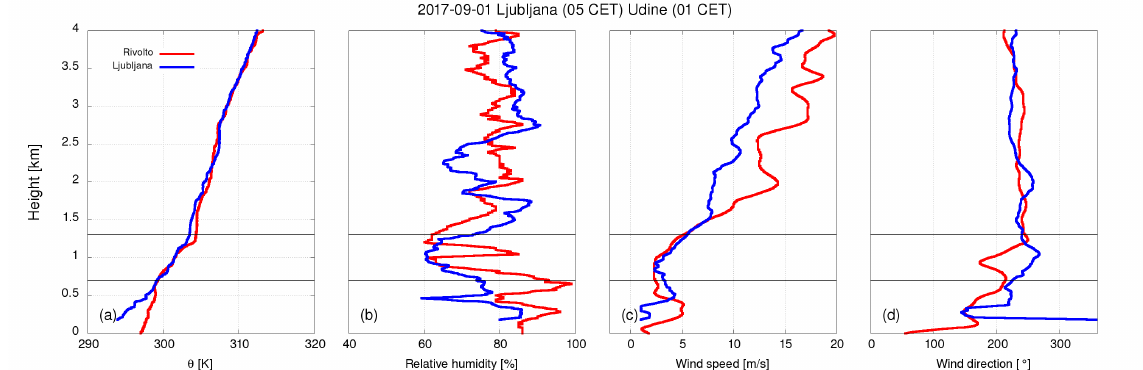
Figure 3. Radiosonde profiles from Ljubljana (blue) at 5:00 CET and Rivolto (red) at 1:00 CET on 1 September 2017. ( a ) Potential temperature ( θ ); ( b ) Relative humidity; ( c ) wind speed and ( d ) wind direction. Horizontal lines at 0.7km and 1.4km denote significant slope changes in the relative humidity, potential temperature, and wind speed profiles. The height is relative to